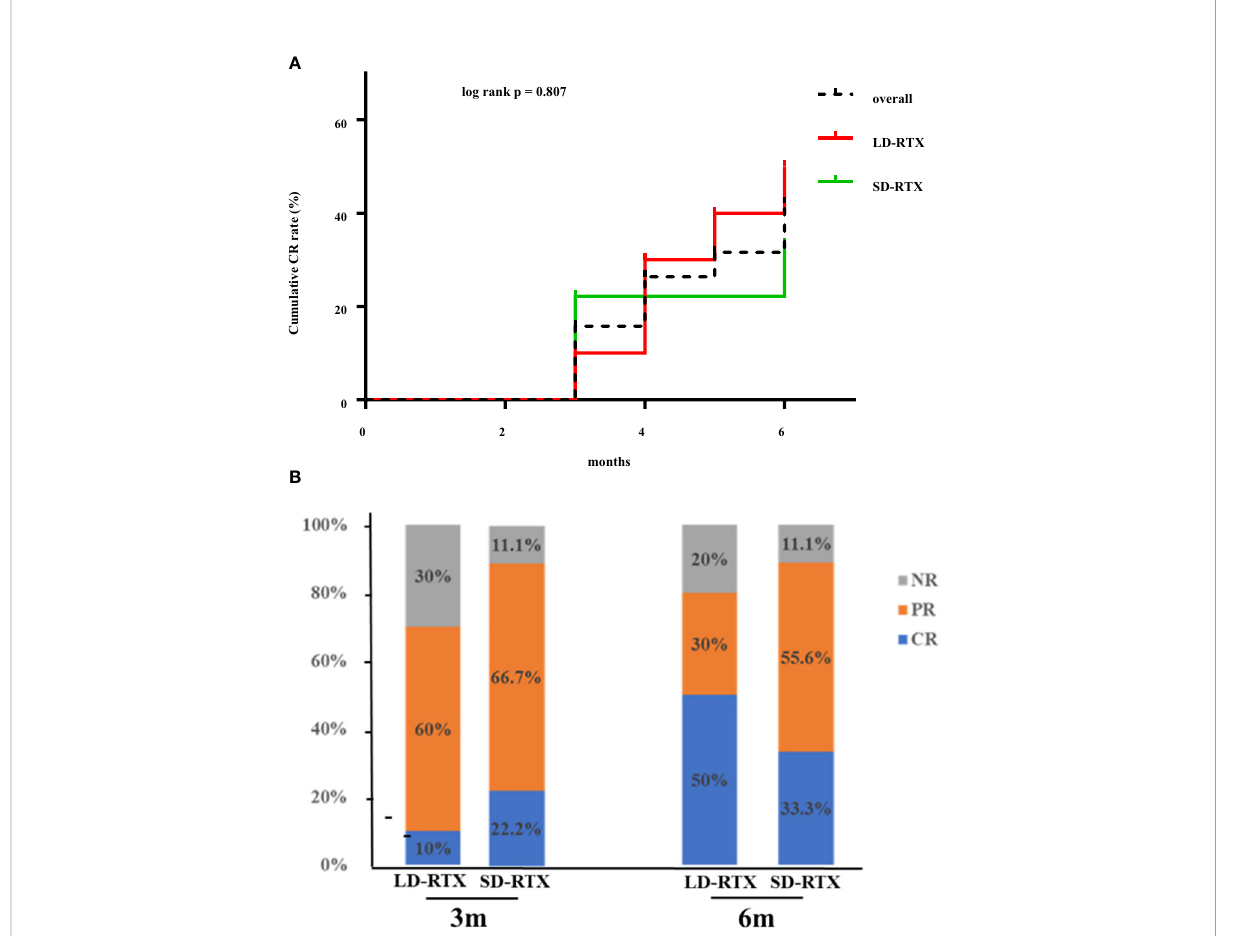
FIGURE 2 Remission rate at 6 months. (A) Cumulative complete remission rate for 6 months after induction therapy between patients with SD-RTX and LD-RTX. (B) Comparison of remission rate between patients with SD-RTX and LD-RTX at 3 months and 6 months. SD-RTX, standard-dose